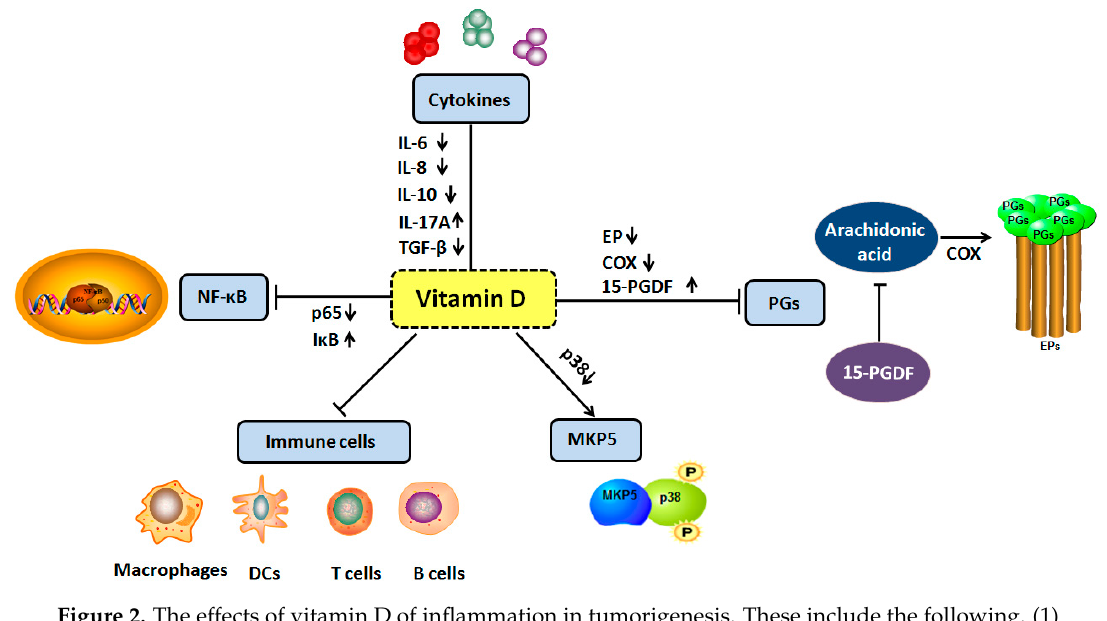
Figure 2. The effects of vitamin D of inflammation in tumorigenesis. These include the following. (1) Regulate the levels of cytokines including IL-6 , IL-8 , IL-17A , IL-10 and TGF- β ; (2) inhibit NF- κ B signaling pathway; (3) up-regulate the expression of MAP kinase phosphatase 5; (4) inhibit the prostaglandins pathway via reducing PG receptors (EPs), decreasing COX-2 expression and increasing 15-PGDH expression; (5) inhibit the immune cells via VDR including macrophages, DCs, B cells and T cells. Upward arrows indicate activation, downward arrows indicate inhibition.